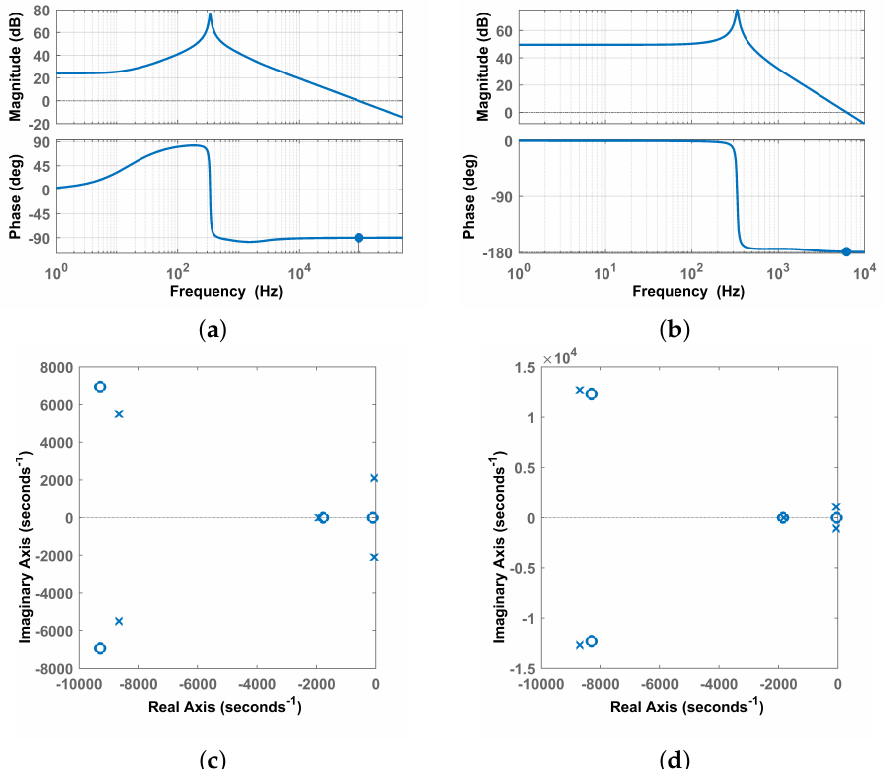
Figure 12. TF buck mode for: ( a ) Bode plot Gi L 1 d _ d _ RC ( s ) . ( b ) Bode plot Gvd _ d _ RC ( s ) . ( c ) Pole and zero map for Gi L 1 d _ d _ RC ( s ) . ( d ) Pole and zero map for Gvd _ d _ RC ( s )